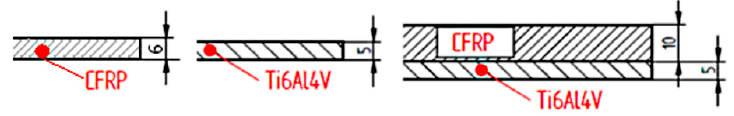
Figure 3. Schemes of the stacks which have been tested.